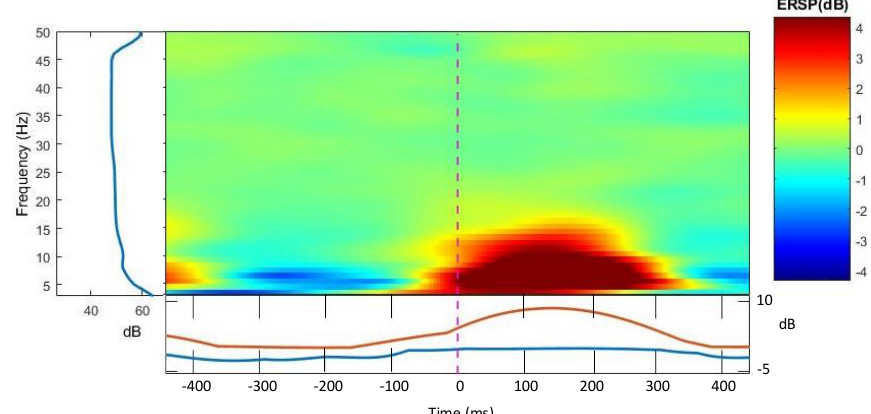
Figure 7. Frequency analysis performed with EEGlab software showing mean power spectrum and mean event-related spectral perturbation (ERSP) for the time-period from −400 ms before until 400 ms after left initial IC onset for the left hemisphere EEG channel C3, averaged over the datasets of all three volunteers.